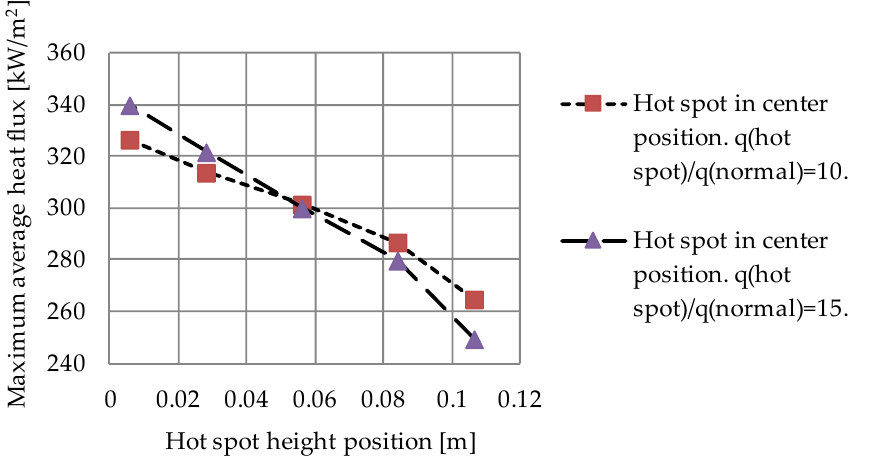
Figure 10. Maximum average heat flux as a function of hot spot vertical position.